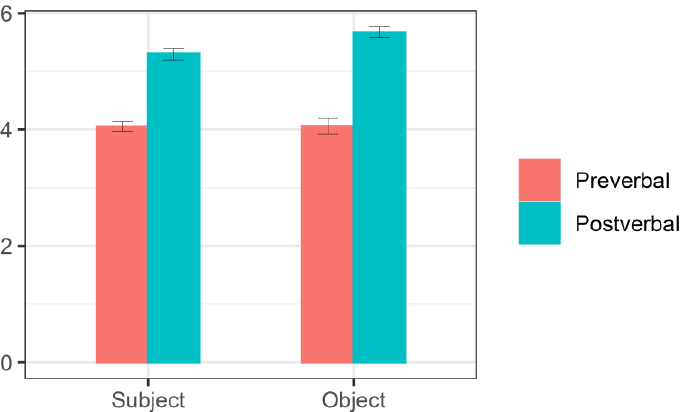
Figure 2 . The acceptability rating experiment: Average scores by category and position . Figure 2. The acceptability rating experiment: Average scores by category and position. In the preverbal position, subjects and objects received the same rating